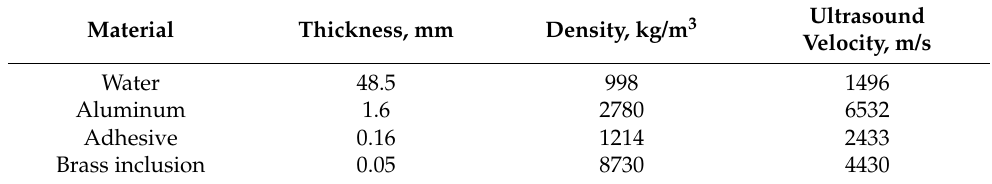
Table 1. Characteristics of the sample materials and medium.